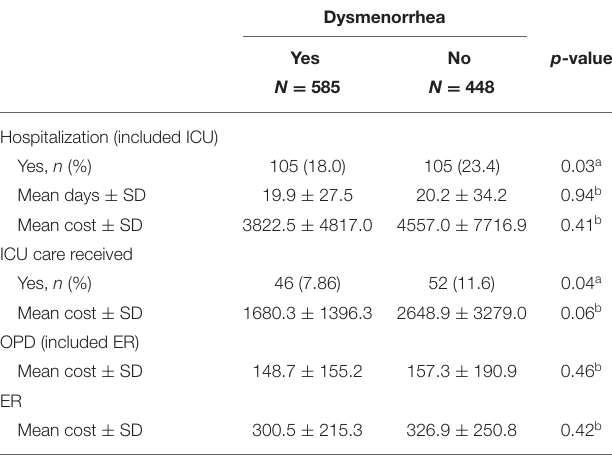
TABLE 5 | Cost of hospitalization, uses of intensive care unit, emergency room, and outpatient visit for patients with stroke compared between women with and without dysmenorrhea.